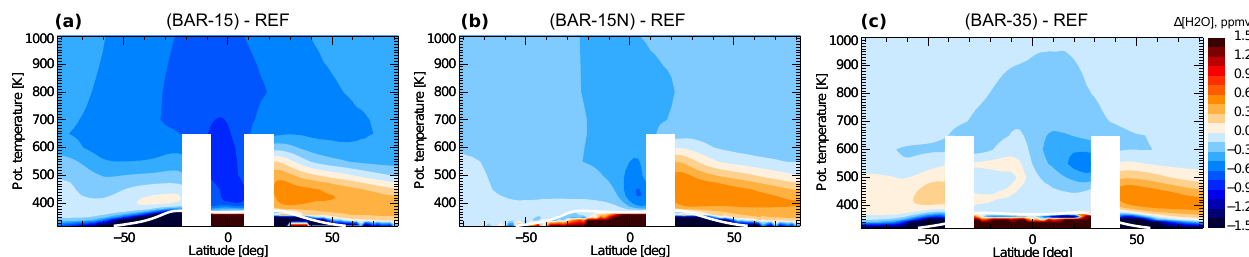
Figure 9. Zonal mean water vapour distributions for 2011. Shown are differences between the CLaMS reference simulation and the sensitivity simulations with the horizontal transport barriers at 15 ◦ N/S (a) , 15 ◦ N/S (b) , and 35 ◦ N/S (c) . Transport barriers are set between the Earth’s surface and the 600K potential temperature levels and are represented in white. Tropopause is represented by a white solid line and is calculated from ERA-Interim reanalysis data.